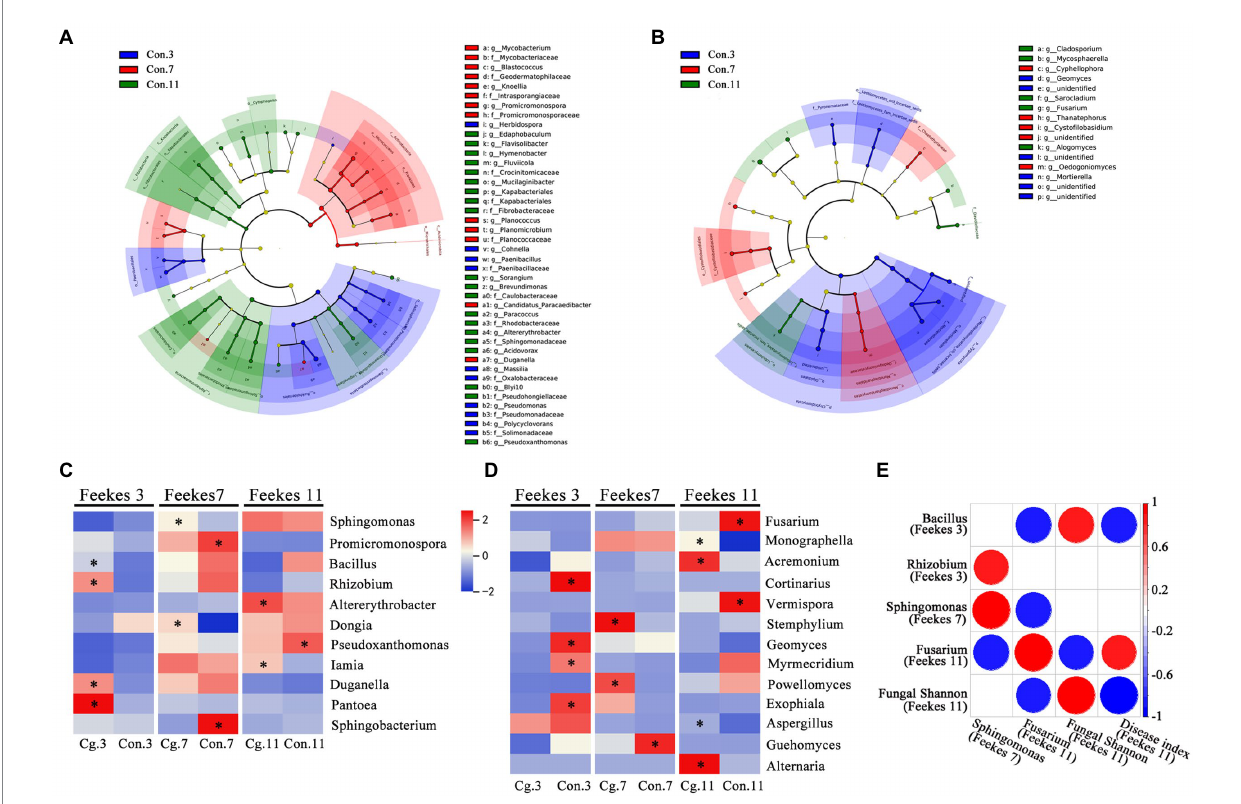
FIGURE 5 LEfSe analysis for identifying biomarkers and correlation analysis. (A, B) LEfSe analysis of the control bacterial (A) and fungal (B) communities among three stages (Feekes 3, 7 and 11) with LDA score (log 10) >3. Different colors represent different treatments; (C, D) LEfSe analysis at genus level between the ‘Cg’ and ‘Con’ treatments at each growth stage for bacterial (C) and fungal (D) communities. Biomarkers in each pair comparison were marked with asterisk and identified with LDA score (log 10) >3 for bacteria (C) and >2 for fungi (D) , respectively. Colors represent relative abundance of each biomarker in all treatments, and the genera from top to bottom were ordered according to the decreased total relative abundance. Bacterial genus Rhizobium represents Allorhizobium , Neorhizobium , Pararhizobium and Rhizobium ; (E) Spearman correlation analysis among relative abundance of some biomarkers, fungal Shannon and disease indices. Correlations with p < 0.05 were visualized by circles and colors represent Spearman